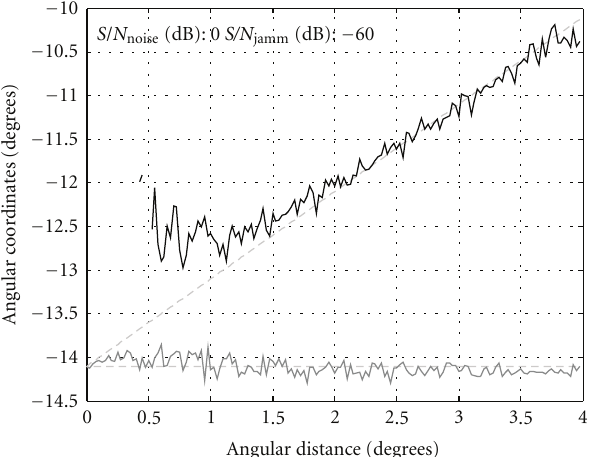
Figure 7: Histogram of polar coordinates evaluated by using the ESPRIT method at S/N noise = 0dB and S/N jamm = − 60 dB.